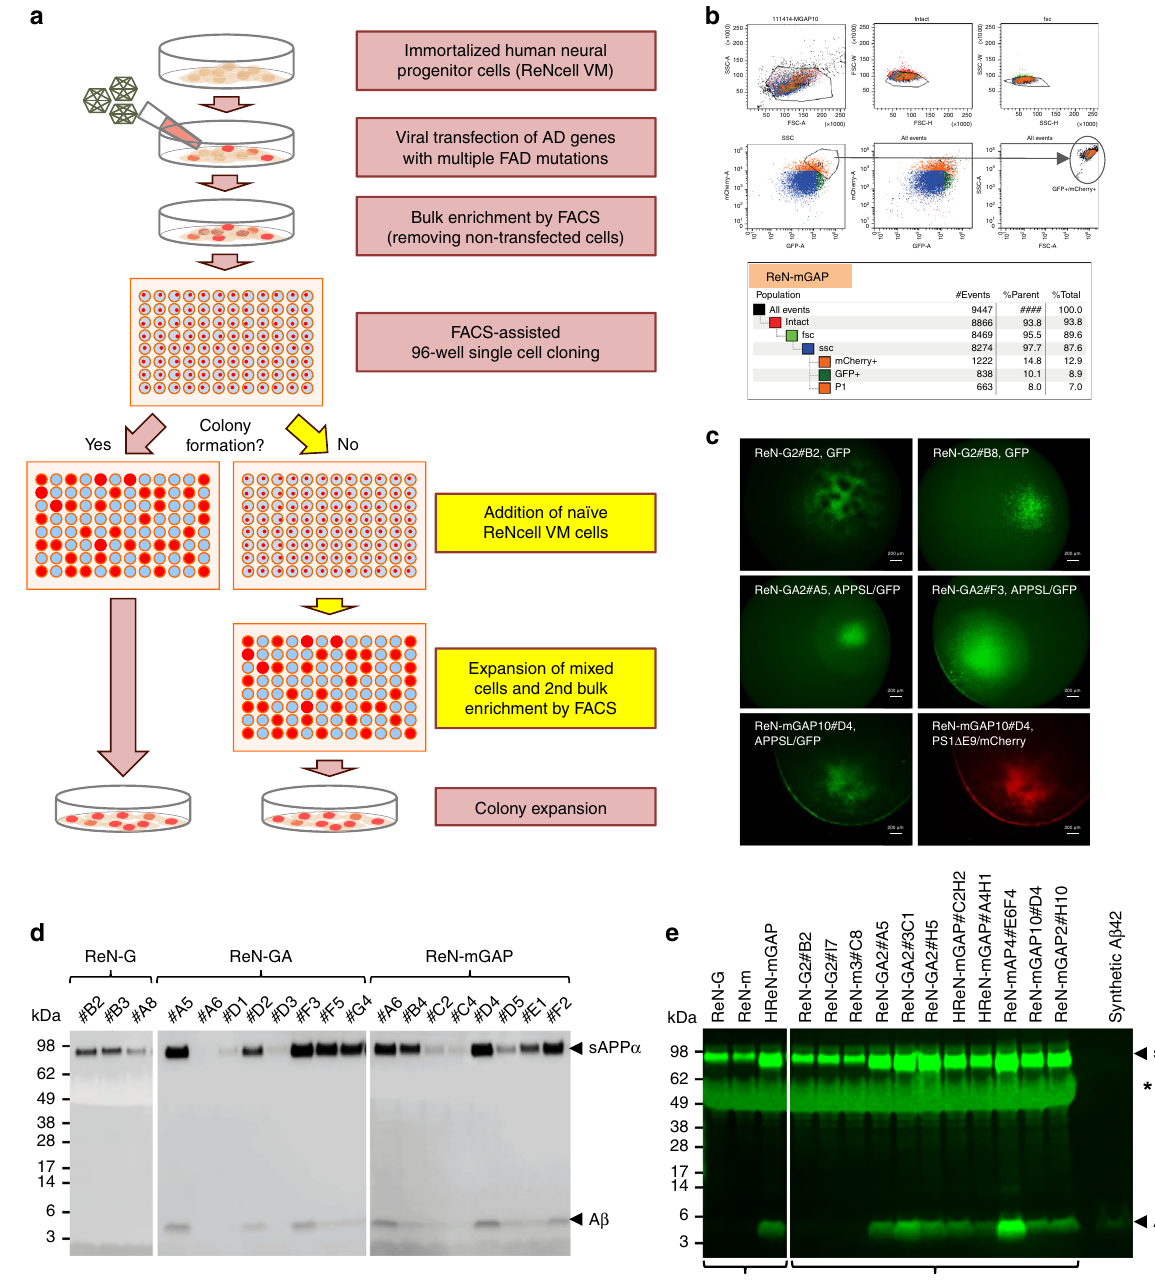
Fig. 1 Generation of clonal control and FAD hNPCs using FACS-assisted single cell sorting. a A work fl ow for preparing clonal hNPCs using FACS- assisted single cell sorting protocol. The heterogeneous FAD hNPCs were prepared by expressing lentiviral DNA constructs harboring APP Swe/Lon (APPSL) and/or PS1 Δ E9 in naïve hNPCs (ReNcell VM). Non-AD control cells were generated by expressing lentiviral DNA constructs harboring GFP (ReN-G) or mCherry (ReN-m). In case of HReN-mGAP cells, ReN-G2 cells were infected with lentiviral particles harboring APPSL-IRES-PS1 Δ E9-mCherry. The heterogeneous parental control and FAD hNPCs were subjected to FACS-assisted single cell sorting and grown for 2 weeks to develop colonies. Slow growing single clones were augmented with naïve hNPCs without expressing GFP or mCherry to facilitate cell proliferation. When the cells were con fl uent, fl uorescence-positive clonal hNPCs were collected by an additional FACS sorting protocol. b Gating strategy of FACS-assisted 96-well single cell sorting for ReN-mGAP cell line. For all viable cells, mCherry fl uorescence intensity (mCherry-A) was plotted as a function of GFP fl uorescence intensity (GFP-A). The P1 area was gated to select an overlapped region between high-GFP (8.9% of the GFP positive population) and high-mCherry (12.9% of the mCherry population) signals. Each individual cell within 7% of the gated population was placed into a single well of Matrigel pre-coated 96-well plates. c Colony formation of representative FACS-assisted clonal hNPCs in 96-well plates. Scale bars represent 200 μ m. d Western blot analysis of A β levels in conditioned media from 2D-expanded clonal hNPCs derived from heterogeneous ReN-G, ReN-GA and ReN-mGAP cells. Secreted/soluble A β s and sAPP α s were detected using anti-A β antibody (6E10). e Analysis of A β in media from 2D-expanded clonal FAD hNPCs. Selected clones from each parental group were grown in 6-well plates under expansion conditions. After 48 h, media was collected. Secreted/soluble A β s and sAPP α s were detected using anti-A β antibody (6E10). Asterisk represents a nonspeci fi c